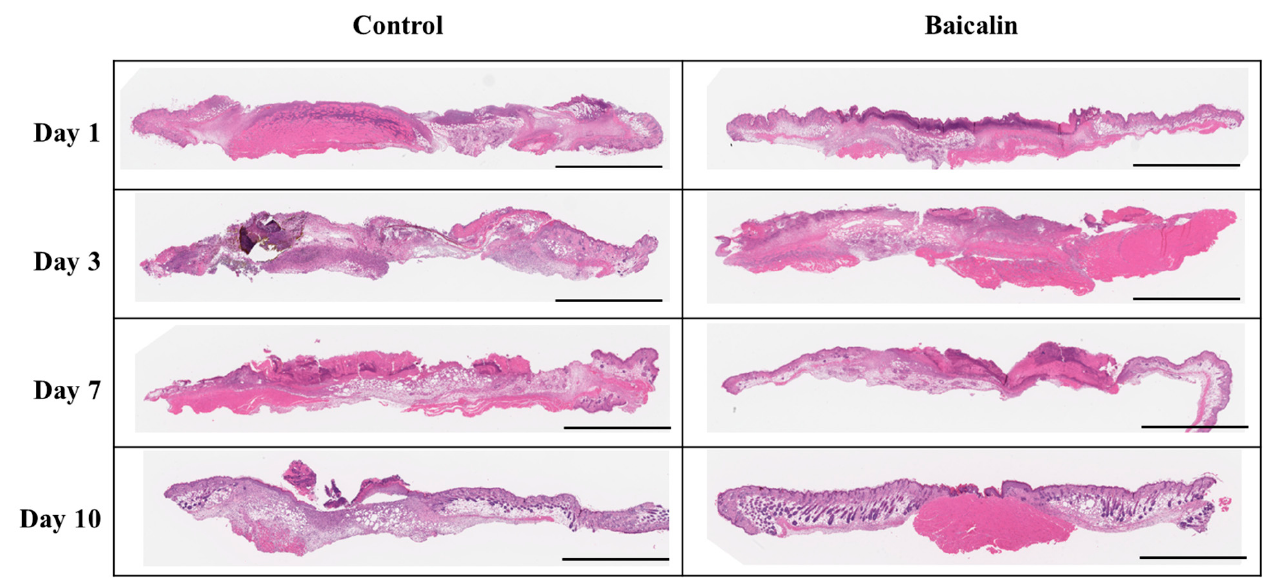
Figure 3. Histological analysis of the effect of baicalin on skin structure in murine pressure ulcers. Skin tissue samples from each group were collected on days 1, 3, 7, and 10 after treatment with baicalin and were stained with hematoxylin and eosin (H&E). All images are representative of three independent experiments ( n = 18). Scale bar: 4 mm.